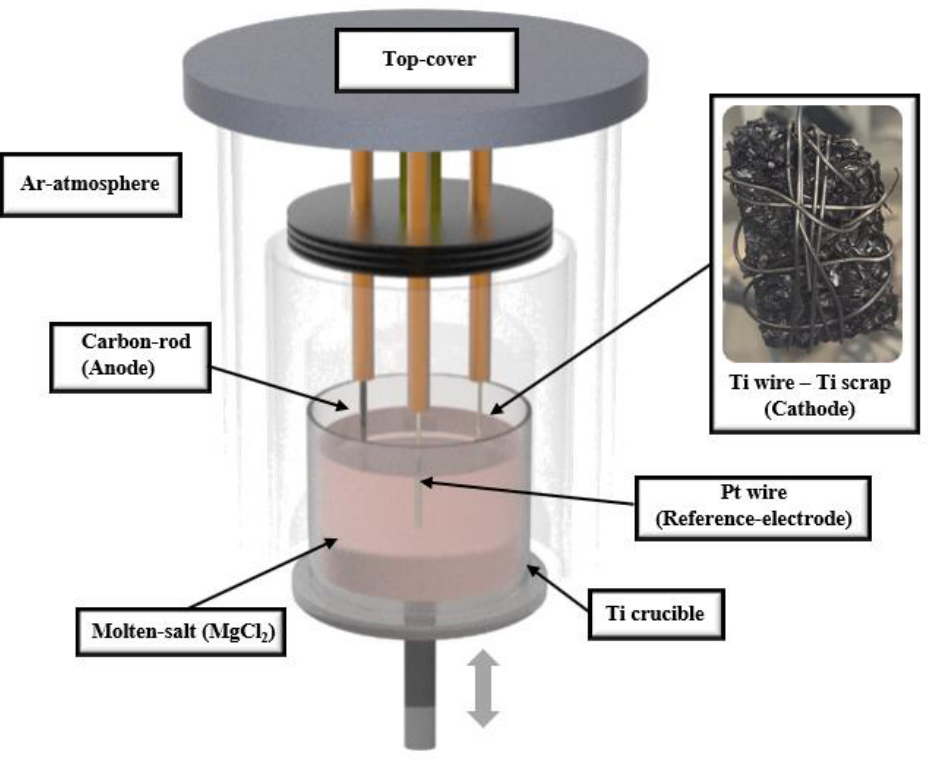
Figure 1. Schematic diagram of device structure for electrolytic deoxidation process.